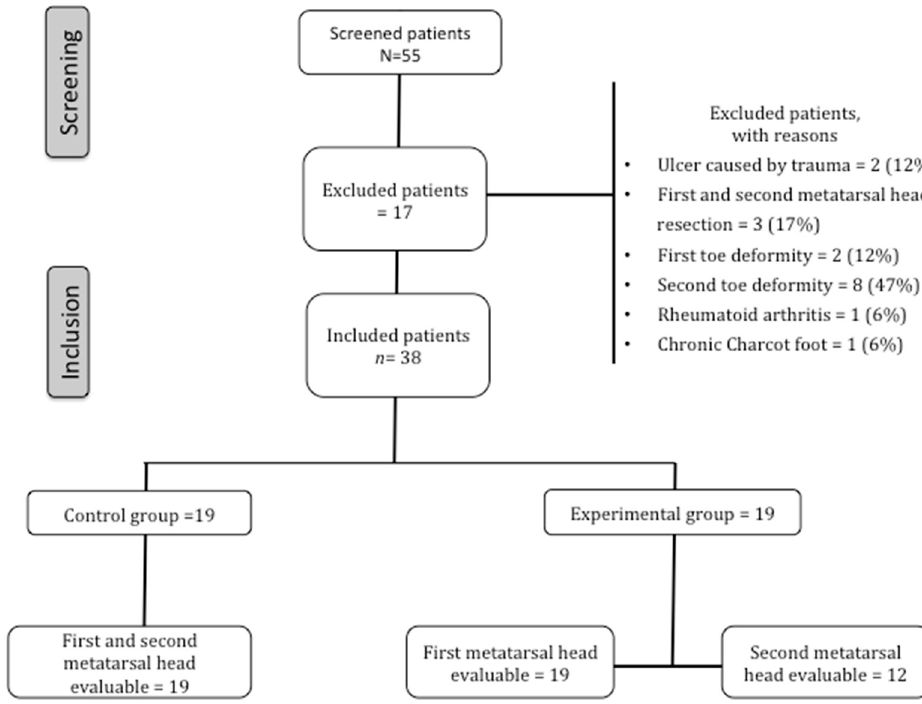
Figure 2. Flow chart of the included patients.